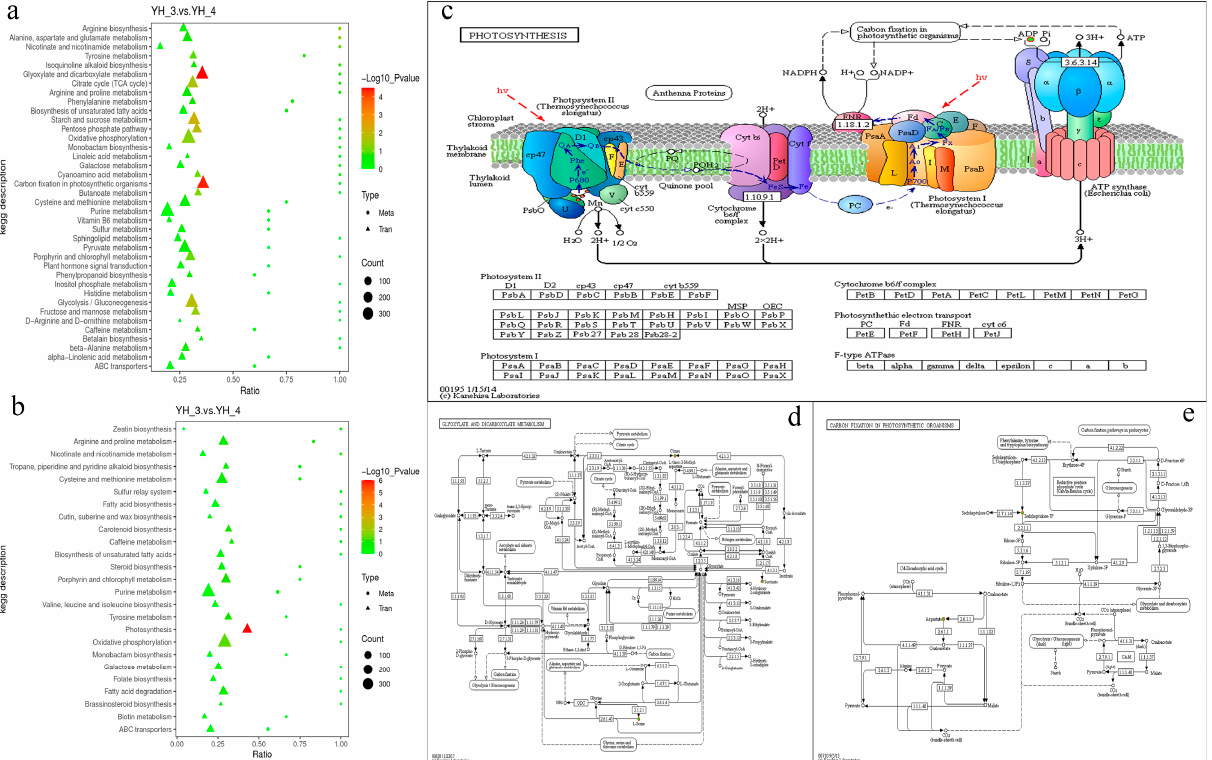
Figure 6. Joint analysis of the DEGs and DAMs in YH_3 vs. YH_4. ( a ) Scatter plot of differential genes and metabolites in positive polarity mode. ( b ) Scatter plot of differential genes and metabolites in negative polarity mode. ( c ) The DEGs and DAMs simultaneously mapped to photosynthesis (ko00195). ( d ) The DEGs and DAMs simultaneously mapped to glyoxylate and dicarboxylate metabolism (ko00630). ( e ) The DEGs and DAMs simultaneously mapped to carbon fixation in photosynthetic organisms (ko00710). Solid circles in green indicate the metabolites noted, red circles represent a significantly upregulated gene or metabolite, blue circles represent a significantly downregulated gene or metabolite, and solid circles in green represent a gene that is both upregulated and downregulated.